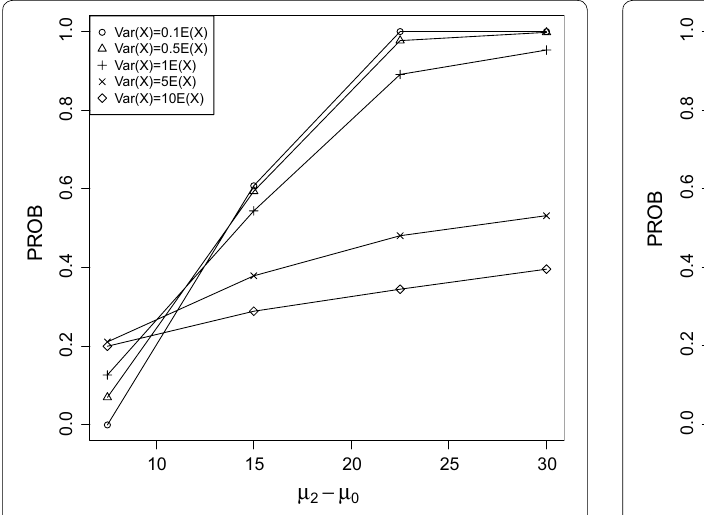
Fig. 12 PROB of the CPCAT; µ 0 = 125 , increasing trend